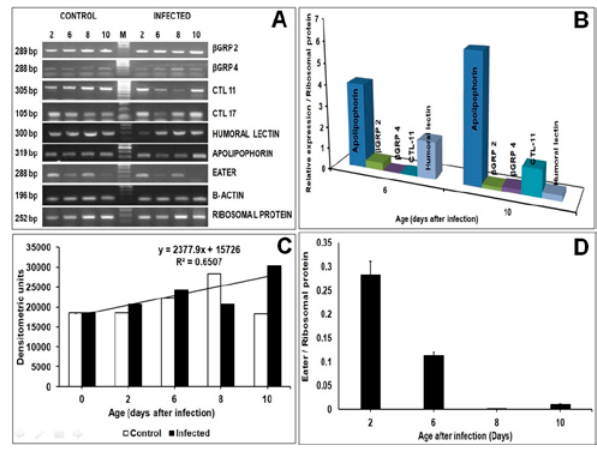
Figure 6 A-D. Modulation in expression of immune genes in hemocytes of B. mori larva after infection with N. bombycis : (A) RT-PCR profile of gene expression of different genes including cytoskeletal protein gene β- Actin and the house keeping gene encoding ribosomal protein resolved from hemocytes collected from control and infected larvae at 2, 6, 8 and 10 days after infec- tion. M- Massruler DNA marker (Thermo). (B) qPCR showed relative expression of different immune genes in hemocytes at 6 and 10 h after infection. (C) β- Actin, the cytoskeletal protein gene showed gradual increase in expression represented by den- sitometric units. Increase in expression was correlated with age after infection shown by allometric line. The linear regression formula and correlation coefficient are inserted. (D) Relative expression pattern of the phagocytosis associated gene Eater like after standardization with expression of the house keeping gene, ribosomal protein and after elimination of control value.